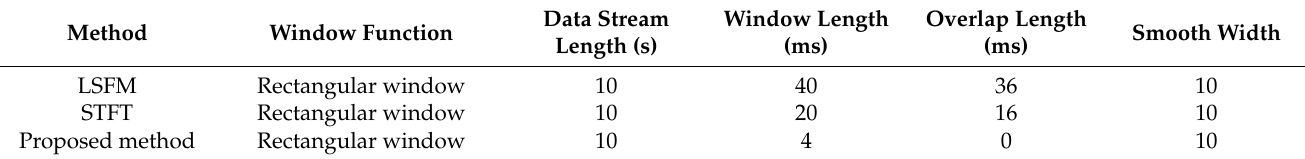
Table 1. The parameters of the three kinds of signal activity detection